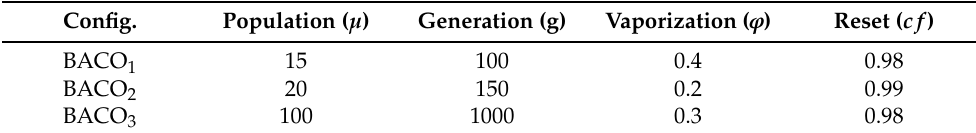
Table 4. Parameter configurations for the BACO algorithm.